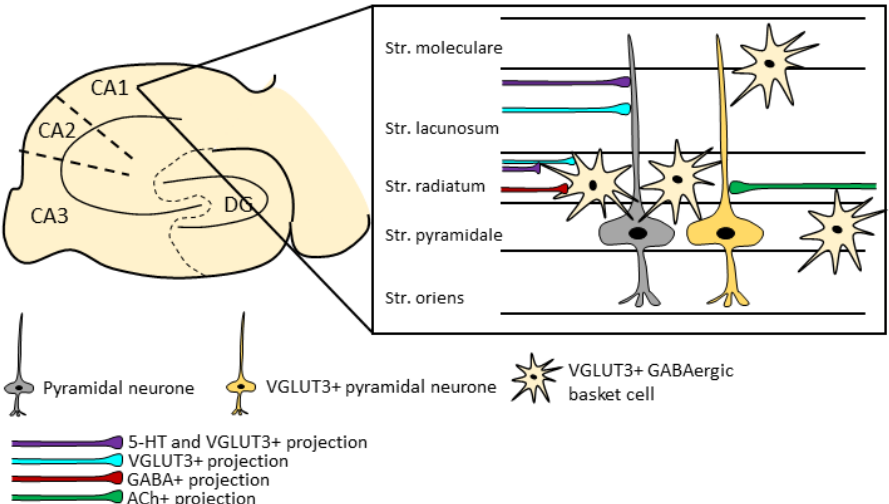
Figure 1. VGLUT3+ neurons and axons in the CA1 region of hippocampus. Local GABAergic interneurons express VGLUT3 and contribute to the proper functionality of the hippocampus. These cells are most prominent in the stratum radiatum, but scarce VGLUT3 positivity can be found in the interneurons of stratum moleculare, stratum lacunosum, stratum pyramidale, and stratum oriens. Additionally, there are some VGLUT3 ‐ expressing pyramidal neurons as well. Punctate labelling from in situ hybridisation and immunohistochemistry experiments indicated VGLUT3+ afferents as well. These are mainly localised in the stratum radiatum and often but not exclusively co ‐ expressed with serotonergic markers. The figure was done based on the work of Fasano et al., 2017; Sz ő nyi et al., 2016; Somogyi et al., 2004; Herzog et al., 2004. 5 ‐ HT: serotonin; ACh: acetylcholine; CA: cornu ammonis; DG: dentate gyrus; str: stratum; VGLUT3: vesicular glutamate transporter type 3.